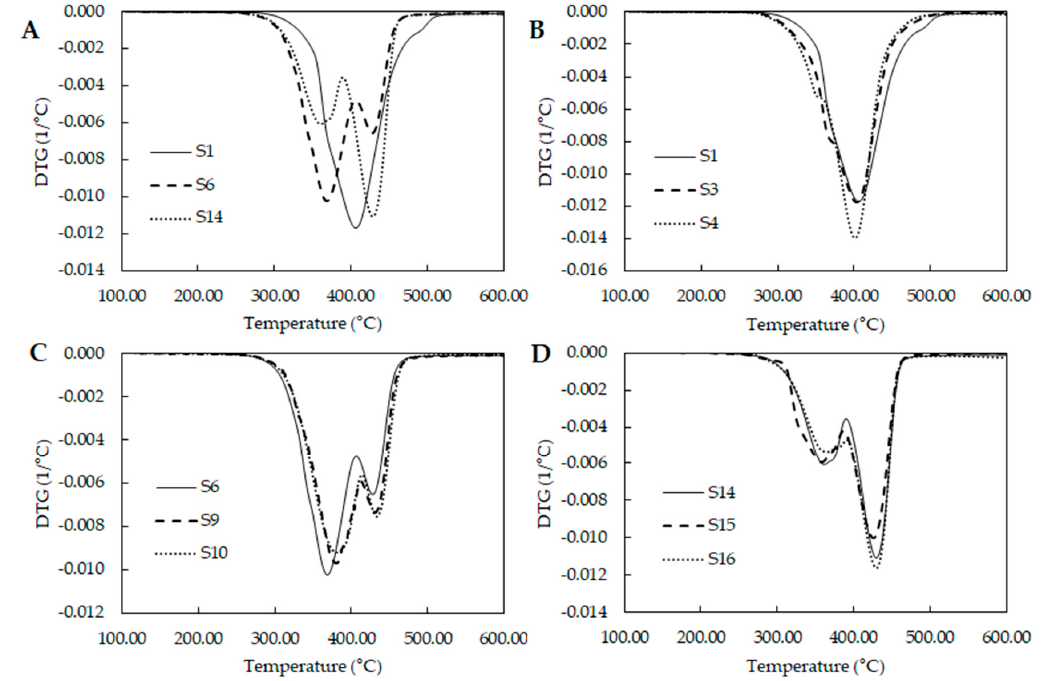
Figure 4. Derivate thermogravimetric curves for different polyol blend combinations ( A ) Comparison of DTGs from the extremes and middle design points. ( B ) DTGs of design points where PCL is the major component, ( C ) DTGs of middle design points and ( D ) DTGs of design points where PEG is the major component.